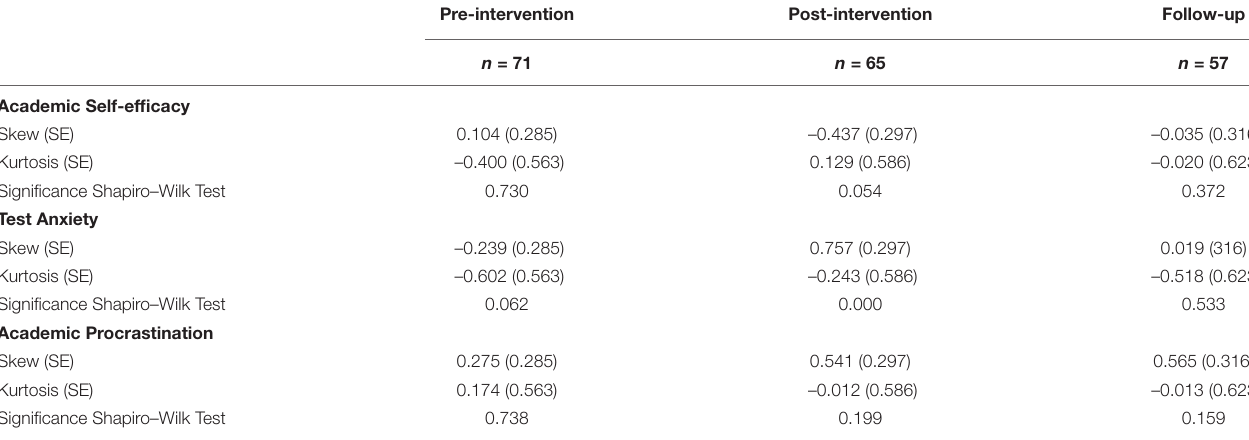
TABLE 4 | Univariate statistics for academic self-efficacy, test anxiety, and academic procrastination. Pre-intervention